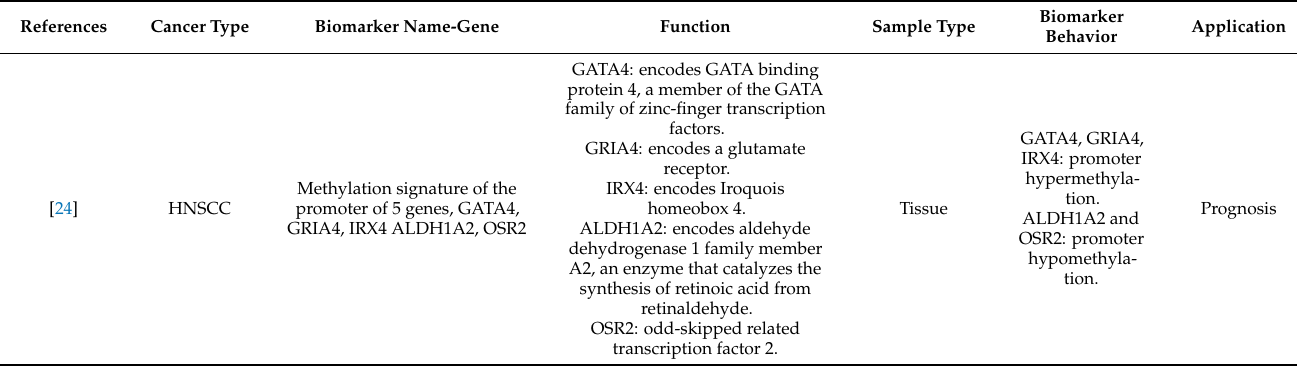
Table 2. Prognostic